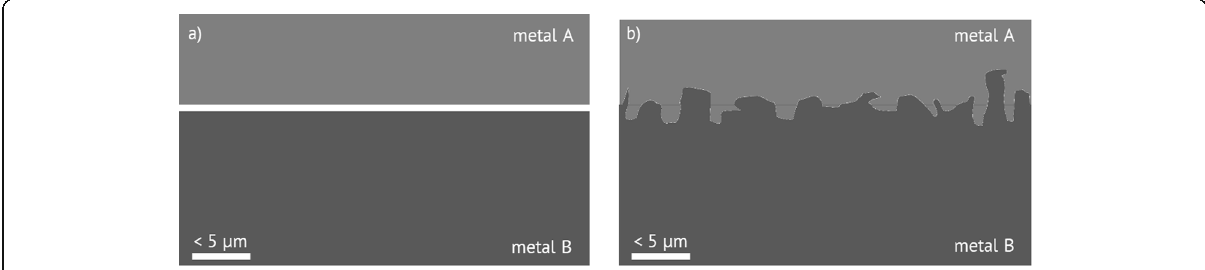
Fig. 1 Mechanism of the joint formation of ultrasonic welded metal/metal joints, schematically a initial state and b after the welding process